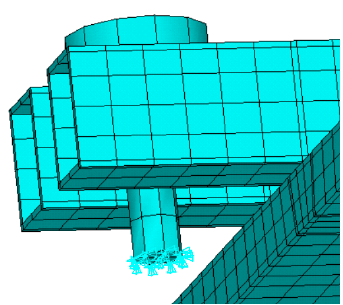
mm, as presented in Figure 9.